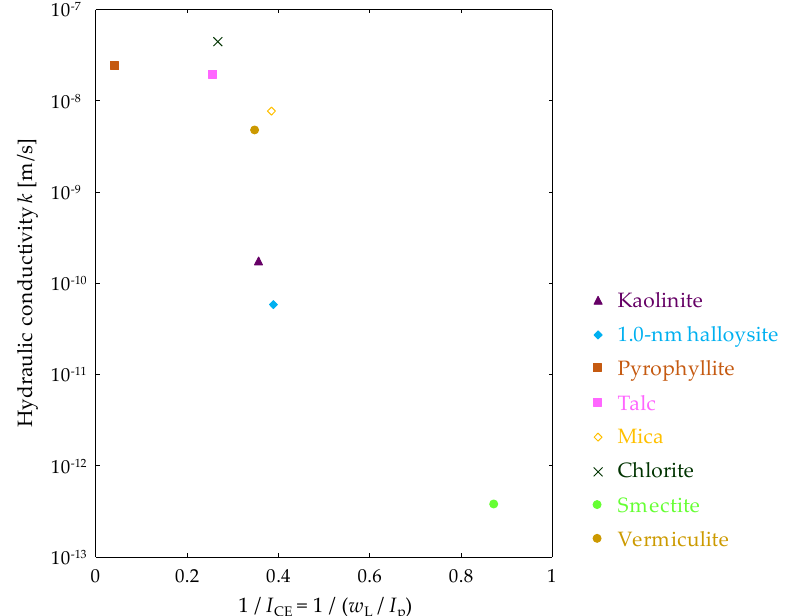
Figure 11. Relationship between hydrogen energy and hydraulic conductivity of clay mineral samples (void ratio = 0.95).